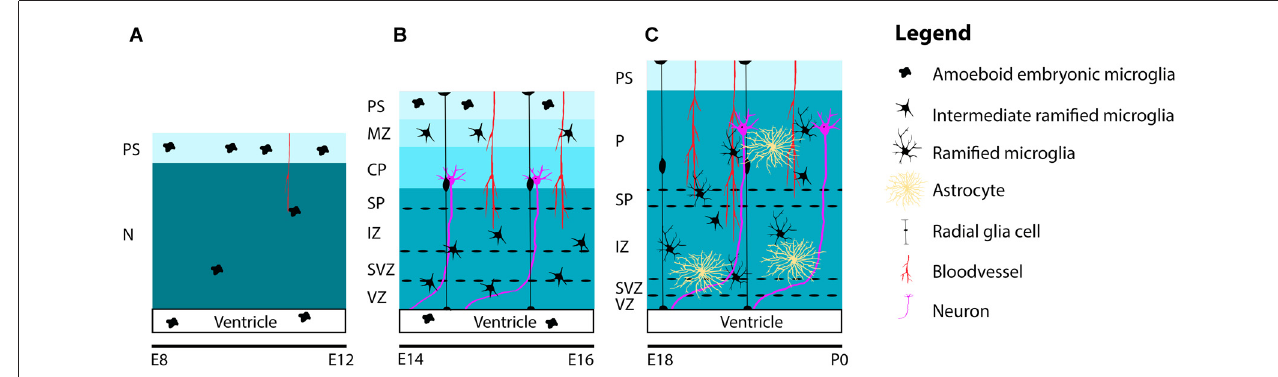
FIGURE 2 | Schematic representation of the distribution and maturation of microglia and the beginning of astrogenesis in the mouse cerebral cortex. (A) At early embryonic stages between E8 and E12, microglia are located at the PS in the meninges and in the lateral ventricles. Only a few highly, motile and proliferative cells can be found in the neuroepithelium. (B) Between E14 and E16, microglia ramify further to form intermediate ramified microglia that can be found in the VZ, SVZ, IZ, SP and MZ. At the PS and in the lateral ventricle, one can still detect amoeboid microglia. Remarkably, until E16, microglia are absent from the cortical plate. (C) From E18 and onwards, microglia can be found in the cortical layers, after migrating from the deeper to the more superficial layers. During this period, microglia are found in close association with radial glia, blood vessels and developing axons. Around E18 astrogenesis starts. Similar to microglia, astrocytes are also found near radial glia, blood vessels and axons. Along the course of embryonic brain development, many microglia ramify further and transform from intermediate ramified microglia into mature ramified microglia with long processes. Abbreviations: PS, pial surface; N, neuroepithelium; MZ, marginal zone; CP, cortical plate; SP, subplate; IZ, intermediate zone; SVZ, subventricular zone; VZ, ventricular zone; P,